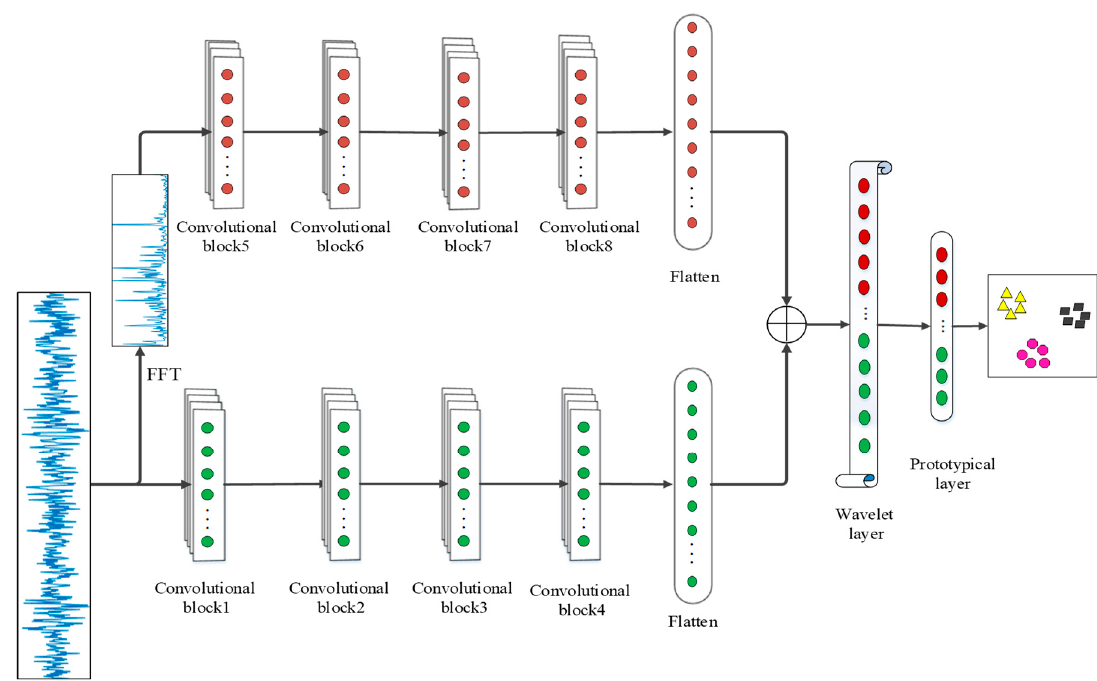
Figure 2. The architecture of the wavelet-prototypical network based on fusion of time and frequency domain (WPNF).